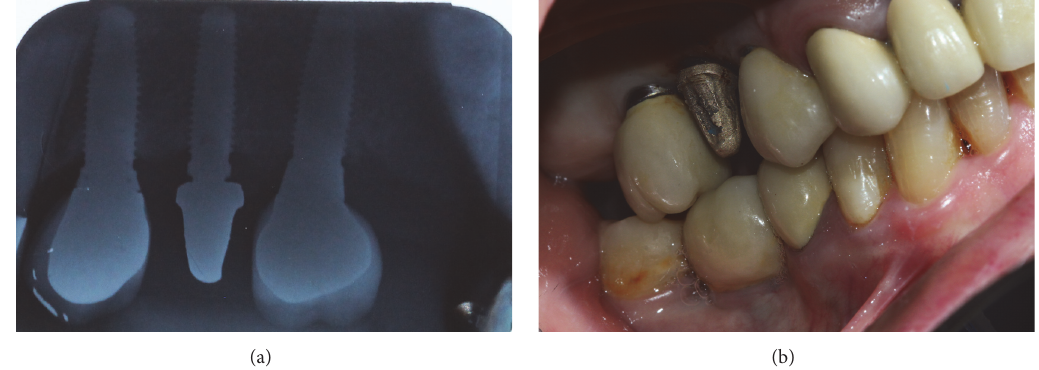
Figure 4: Sealing and adaptation were made: (a) radiographic control and (b) disclosing wax verifications.